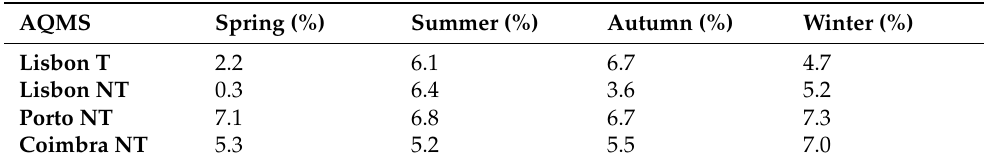
Table 4. Seasonal averages (%) for all